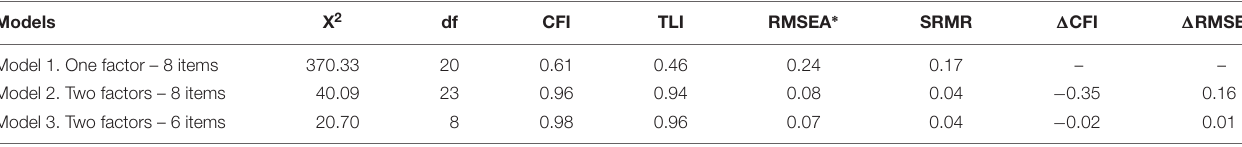
TABLE 1 | Goodness-of-Fit indexes of challenge-hindrance appraisal of job insecurity scale ( N = 306). Models X 2 df CFI TLI